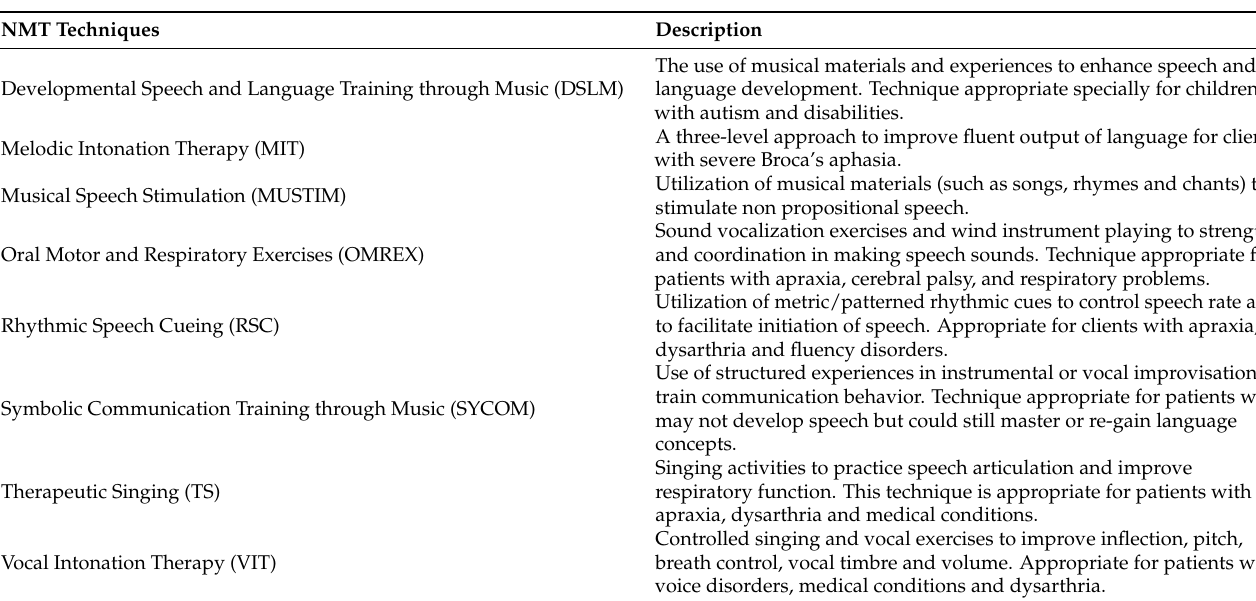
Table 1. NMT speech and language techniques.